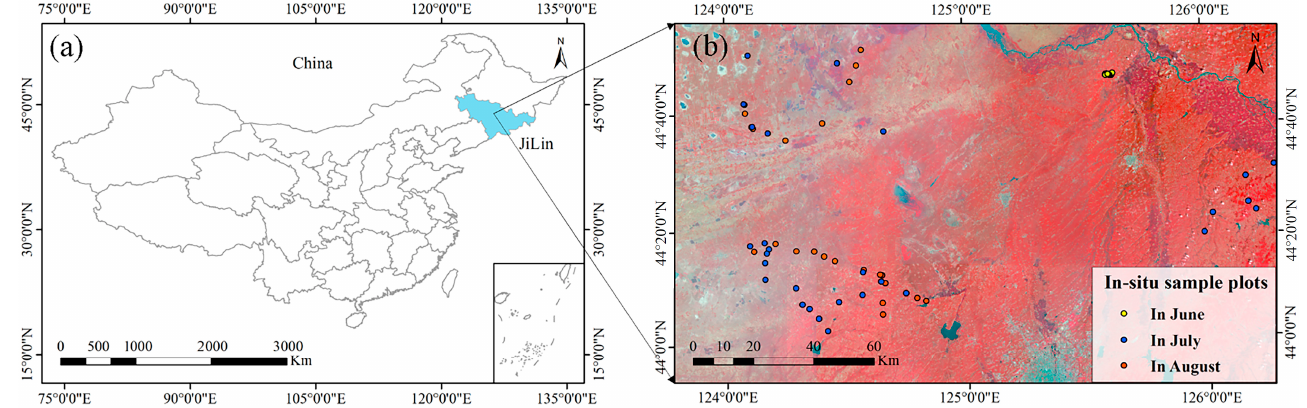
Figure 1. Study area ( a ) and the location of sampling points ( b ). The image in display is false color